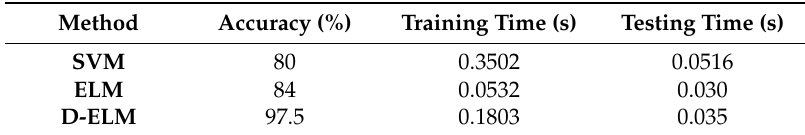
Table 5. Speed comparison of the proposed method with others. (Recognition accuracy is taken from quoted references [17]).